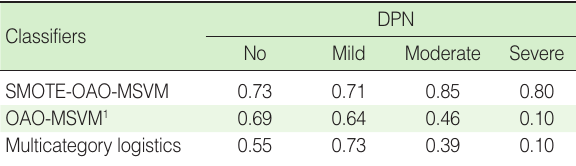
Table 2. The mean accuracy of MSVM with OAO and OAA strategies Kernel Method function